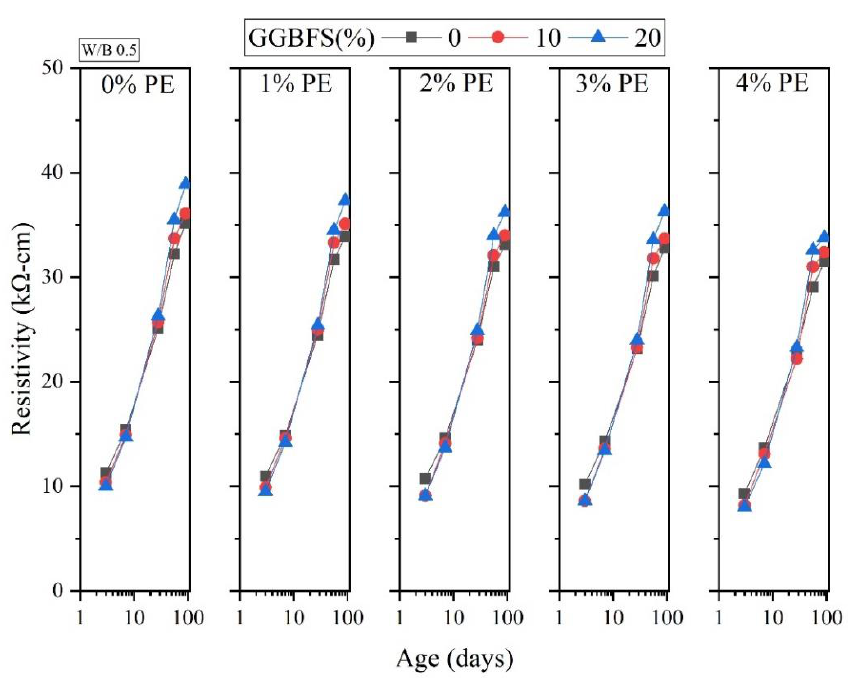
Figure 11. The resistivity of cement mortars with the addition of different ratios of waste PE and GGBFS replacement.